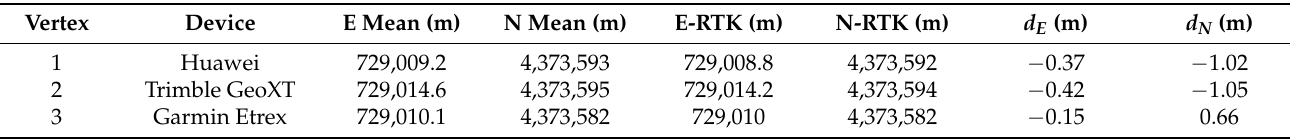
Table 7. Vertices 1, 2, and 3: East, North means of data collected, East, North coordinates from real-time GNSS techniques (E-RTK, N-RTK) and the differences between ( d E , d N ). Vertex